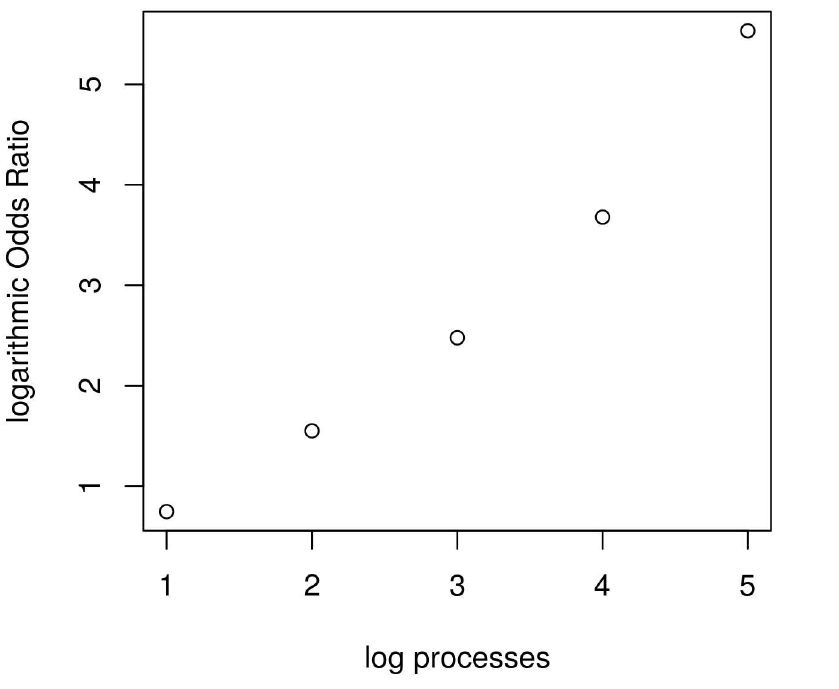
Fig 3. OR Diagram for an increasing number of processors. For (1 − F ( t )) k =